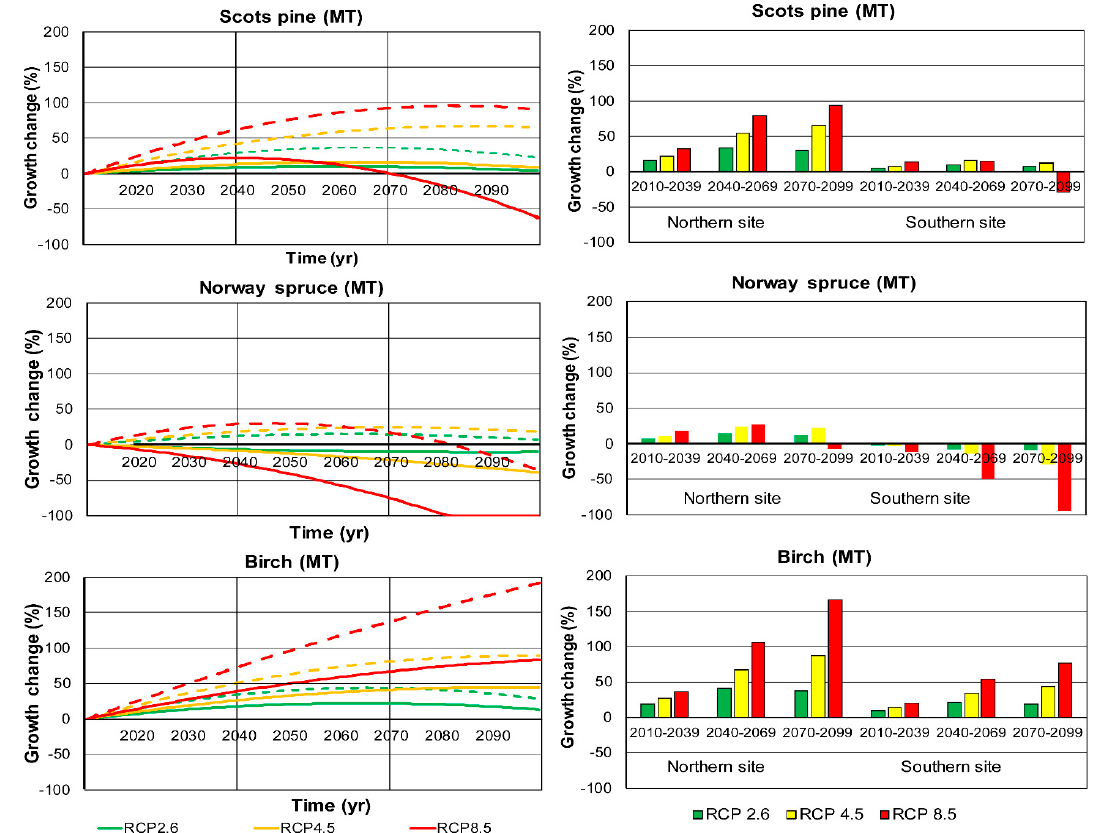
Figure 2. Left: Percentage change of diameter growth response for different tree species over time on the upland medium fertile (MT) sites under minor (RCP2.6), moderate (RCP4.5), and severe (RCP8.5) climate change scenarios in relation to the current climate. Dotted lines indicate the changes in the north (Rovaniemi, 66° N) and solid lines in the south (Tampere, 61° N). Right : Mean percentage change of diameter growth for different tree species on MT sites for 2010–2039, 2040–2069, and 2070–2099 in the north and south on MT sites under different RCPs in relation to the current climate. Table 5. Mean change in diameter growth on quite poor (VT) and medium fertile (MT) upland sites in different tree species in the south (Tampere, 61° N) and north (Rovaniemi, 66° N) under minor (RCP2.6), moderate (RCP4.5), and severe (RCP8.5) climate change scenarios in relation to the current climate. Numbers in parentheses indicate response for corresponding peatland sites (no drought).